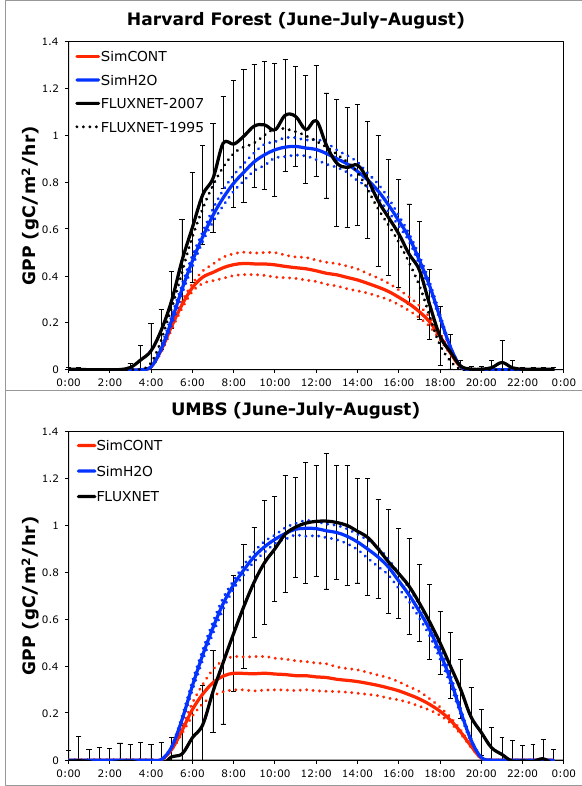
Fig. 9c. (a–c) Comparison between measured and modeled isoprene emission and GPP average diurnal cycles for the time periods indicated in Table 6. Measurements are black lines. Error bars on the measurements represent ± 1 standard deviation. Model results are 10yr climatological averages for SimCONT (red) and SimH2O (blue). The dotted lines represent model uncertainty due to internal variability in the climate model computed as ± 1 standard deviation for n =10 model run years. (c) GPP temperate